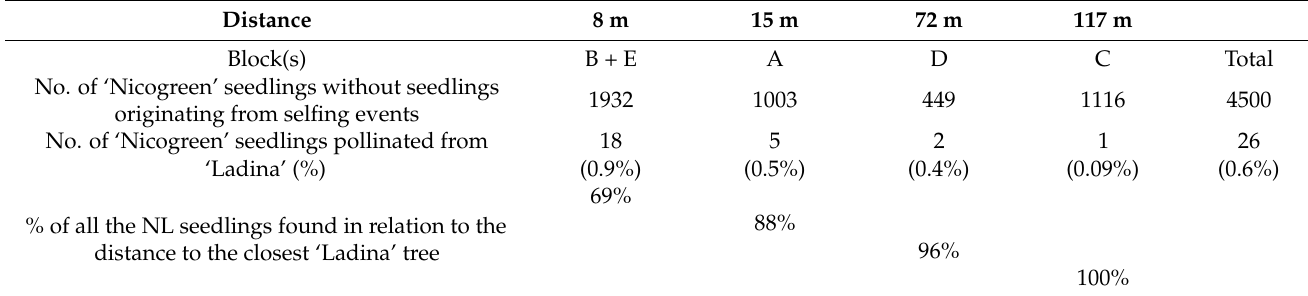
Table 4. Realised ‘Ladina’ pollen dispersal at different distances with combined data from 2018 and 2019. Distance 8 m 15 m